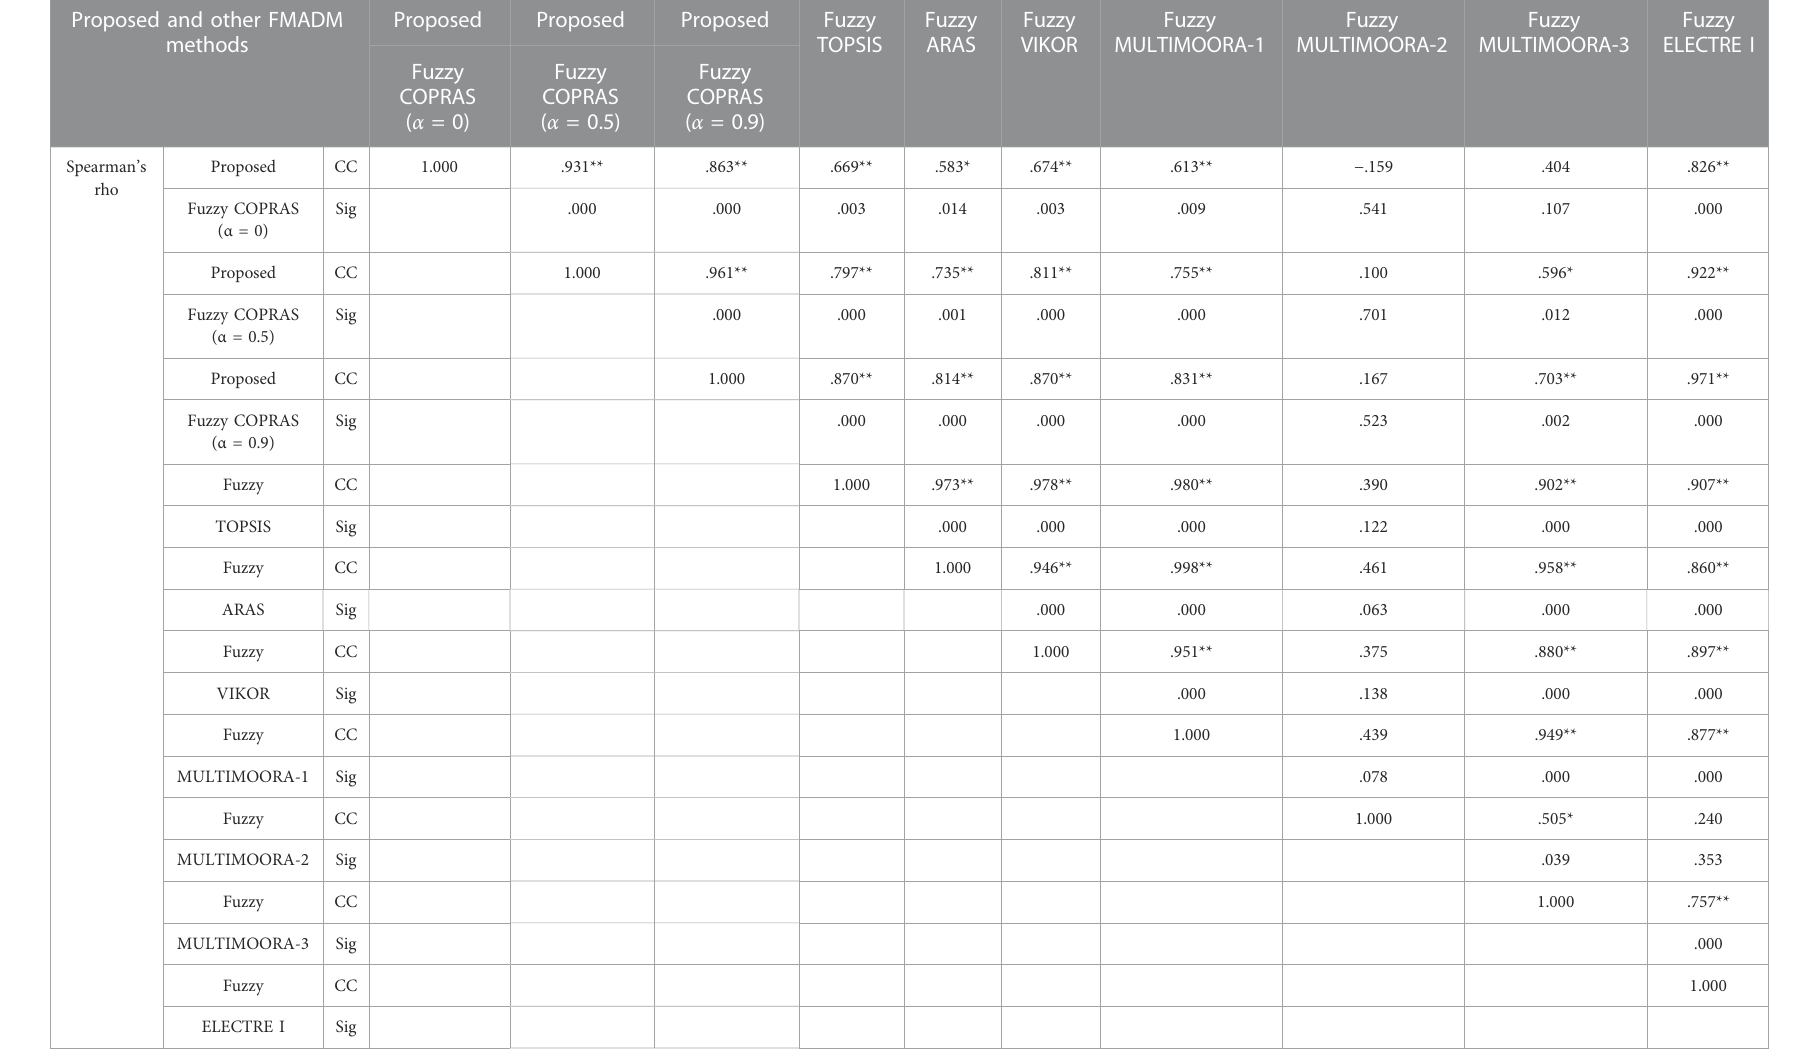
TABLE 6 Results of the Spearman